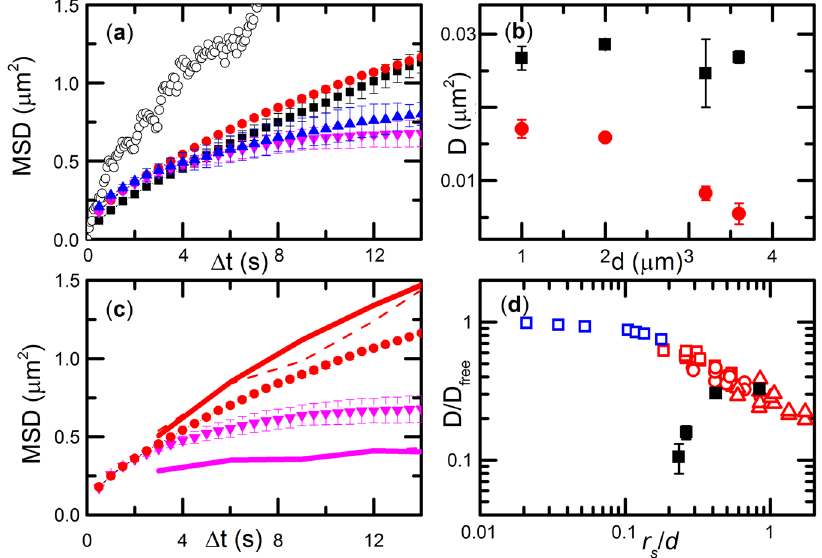
Figure 2. MSD and polymer diffusivity in post arrays. ( a ) Average COM MSD were obtained for d = 1.0 μ m (black), 2.0 μ m (red), 3.2 μ m (blue), and 3.6 μ m (magenta) post arrays. The control (open circles) was measured in the absence of the post array. COM trajectories were obtained by averaging over at least 30 short-term measurements. Error bars denote the difference between two half-ensembles. ( b ) D S (black squares) and D L (red circles) diffusivity in different post arrays. Error bars mark the difference between two ensemble bins. D S is extracted from MSD ( Δ t = 0.5 to 3 s) and D L is extracted from MSD ( Δ t = 3.5 to 14 s). ( c ) Comparison of the average COM MSDs obtained from short-term measurements for d = 2.0 (red circles) and 3.6 (magenta triangles) μ m and from long-term measurements for d = 2.2 (red solid line) and 3.6 (magenta solid line) μ m. MSD( Δ t ) obtained from the stochastic traces for d = 2.2 (red dashed line) and 3.6 (magenta dashed line) μ m are also depicted. ( d ) Comparison with the relative diffusivity dependence for nanoparticles in ref. 23 (blue squares), proteins in 3.9% (red squares), 5.6% (red circles), and 7.4% (red triangles) agarose gel in ref. 3, and DNA in the nanoslit post array (filled black squares). The characteristic spacing between gel fibers in agarose gels was determined from gel